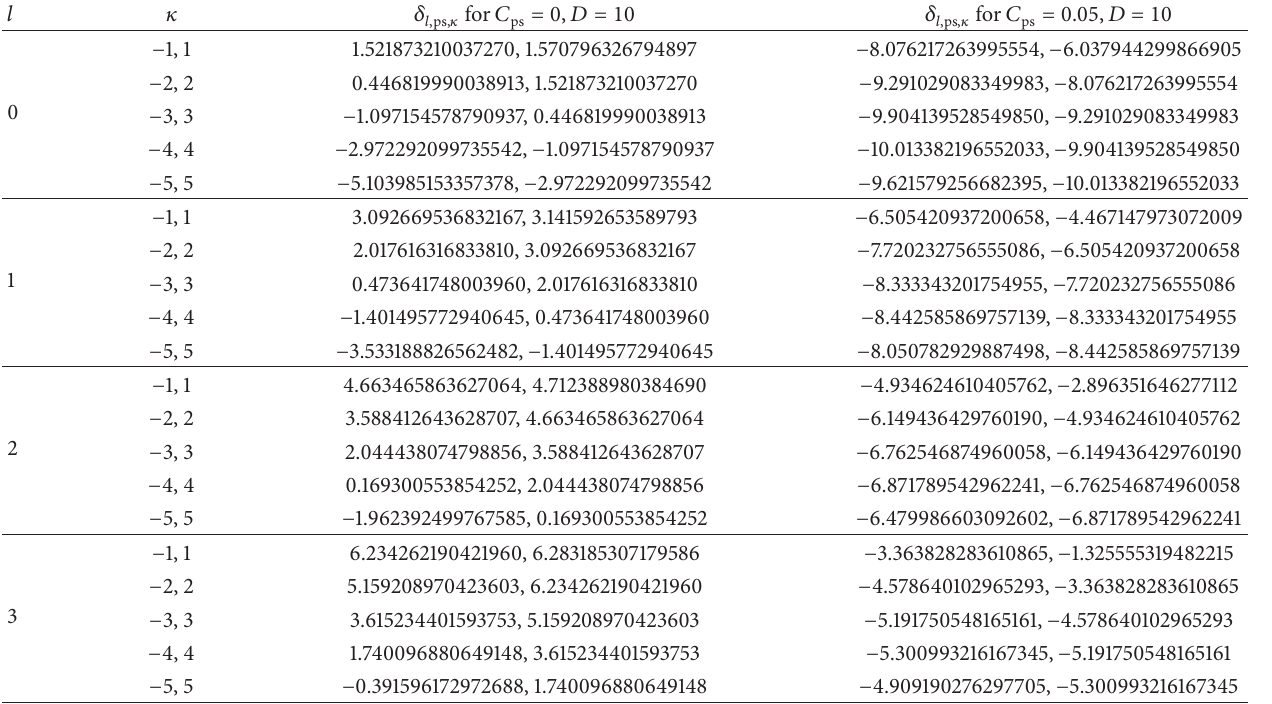
Table 4: Pseudospin scattering phase shifts for hyperbolical potential with positive potential parameter 𝜎 0 = 0.10, 𝛼 = 0.10 , 𝑐 𝑜 = 1/12 , and 𝐸 = 1 . The relativistic mass is 𝑚 = 1 in atomic units (𝑚 = 7 = 1)